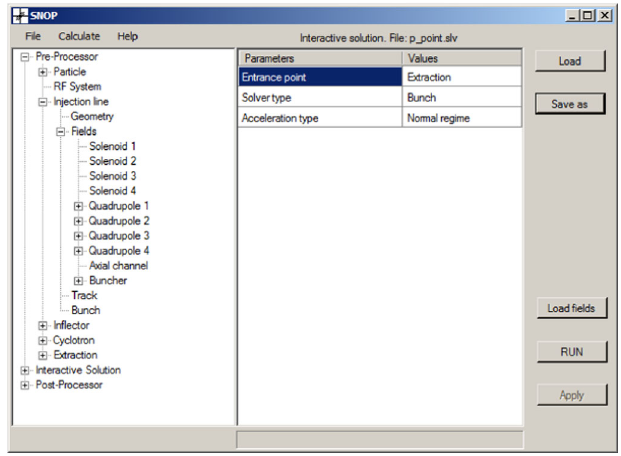
FIG. 6. SNOP main window.